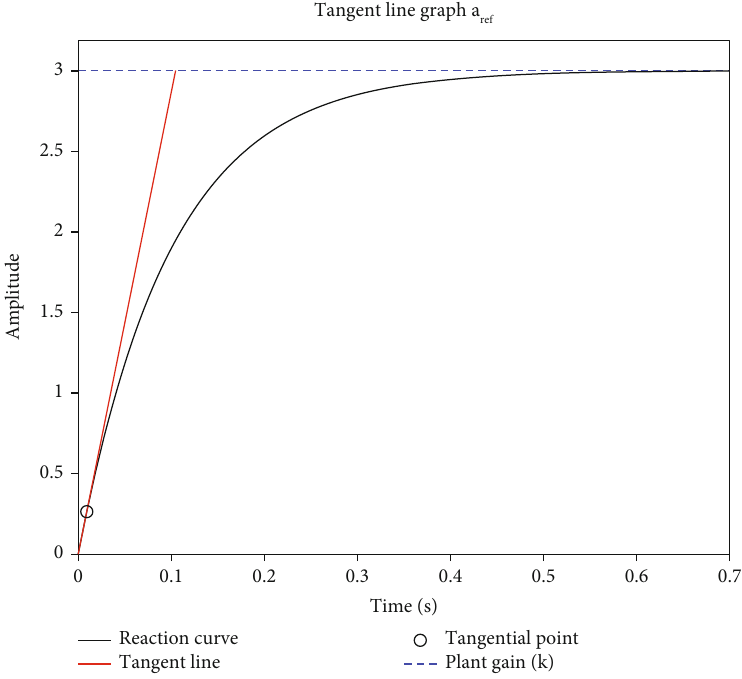
tangent line in open-loop PI ref